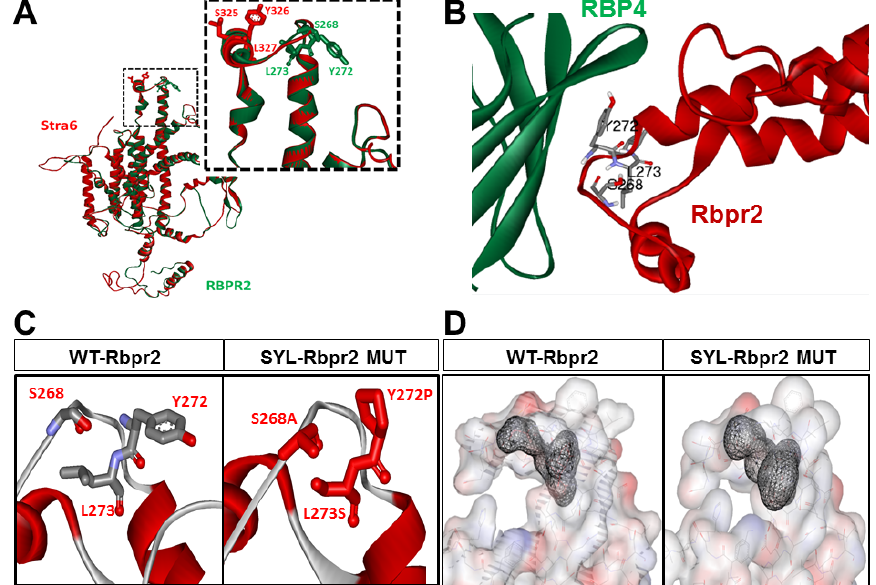
Figure 2. Homology modeling and molecular docking analysis of Rbpr2-RBP4 protein interaction. ( A ) Structural overlay of the homology models generated for human STRA6 (red) and zebrafish Rbpr2 (green) using SWISS-MODEL server. As shown, Rbpr2 and STRA6 share significant structural homology with a conserved three amino acid “SYL”-RBP4 binding domain (large box). ( B ) Rbpr2-RBP4 protein-protein interaction model is shown for zebrafish Rbpr2 and human RBP4 in ribbon view. ( C , D ) Disruption of any of the individual SYL-RBP4 binding residues in the extracellular loop of Rbpr2 is predicted to reduce the free energy gap between native and mutated protein states and affect proper extracellular RBP4 binding and intracellular retinol transport.